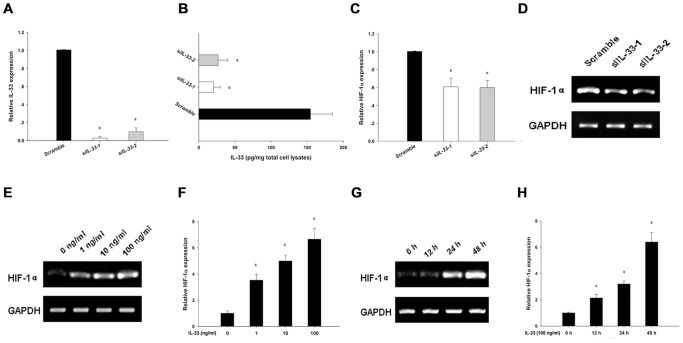
IL-33 enhanced HIF-1α expression in RASF, forming a self-amplification circuit.A-D, Knocking-down endogenous IL-33 compromised HIF-1α expression in RASF. RASF were transfected with IL-33 siRNAs or the control scramble siRNA. 24 h later, IL-33 knocking-down efficiency was determined by realtime PCR (A) and cell lysate ELISA (B). Accordingly, HIF-1α expression levels were assessed by realtime PCR (C) and RT-PCR (D) after IL-33 was silenced (Wilcoxon signed-rank test, *p<0.05 vs. the control scramble siRNA). E-H, Exogenous IL-33 stimulation promoted HIF-1α expression in RASF. RASF were stimulated with different doses (1 ng/ml, 10 ng/ml, and 100 ng/ml, respectively) of recombinant endotoxin-free human IL-33 for 24 h, then were assayed for HIF-1α expression by RT-PCR (E) and realtime PCR (F) analyses. Similarly, after stimulation with 100 ng/ml recombinant endotoxin-free human IL-33 for different time points (12 h, 24 h, and 48 h, respectively), RASF were harvested for detecting HIF-1α expression by RT-PCR (G) and realtime PCR (H) analyses (Wilcoxon signed-rank test, *p<0.05 vs. vehicle control). The results were presented as mean±SEM of four independent experiments.